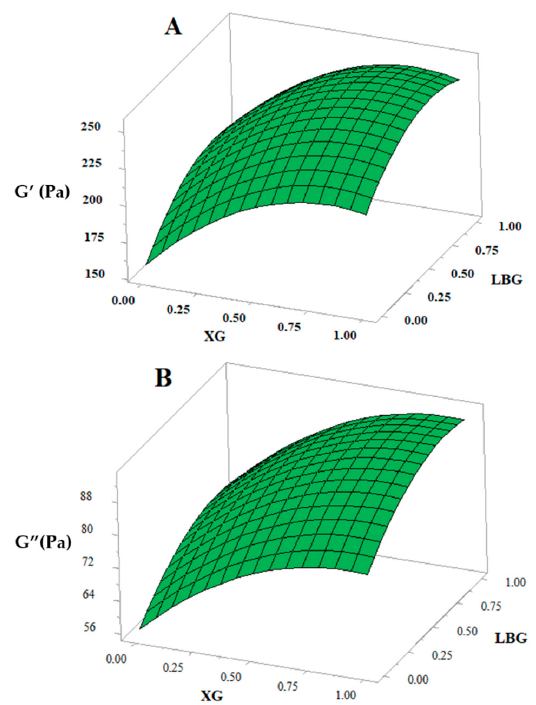
Figure 2. Response surface showing the effect of xanthan gum (XG) and locust bean gum (LBG) on linear viscoelastic properties (G’ and G”) of the